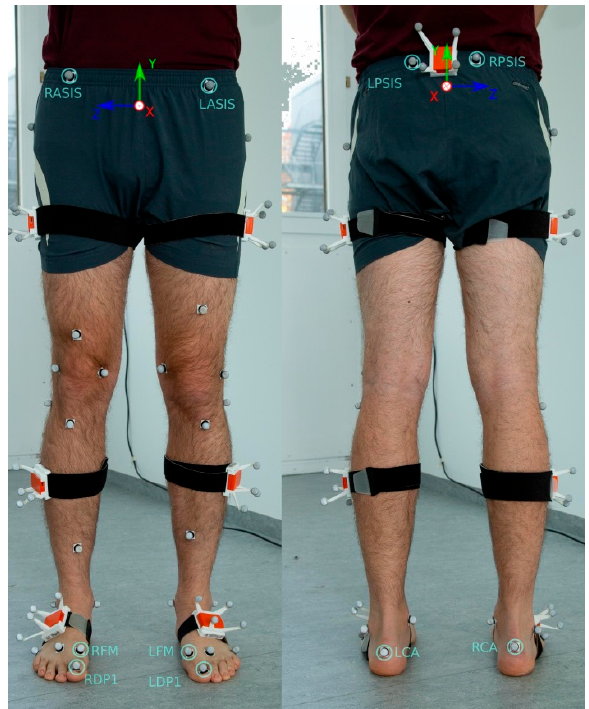
Figure 1. Model picture of the instrumentation with the retroreflective markers and inertial measurement units (IMU). The IMUs were inserted into matched rigid boxes for additional analysis not relevant in the present examination. The markers used for the identification of the initial contact (IC) and terminal contact (TC) events are marked. The calcaneus (CA) markers were used to identify IC, the first distal phalanx (DP1) markers were used to identify the TC in the optical system. In the IMU system virtual representations of the CA and first metatarsal (FM) markers were used to identify the events (see Figure 3). Right Anterior Spina Iliaca Superior (RASIS), Left Anterior Spina Iliaca Superior (LASIS), Right Posterior Spina Iliaca Superior (RPSIS) and Left Posterior Spina Iliaca Superior (LPSIS) markers were used to define the pelvic coordinate system. Consider that in the actual study the above mentioned relevant markers were attached directly onto the skin rather than on clothing.